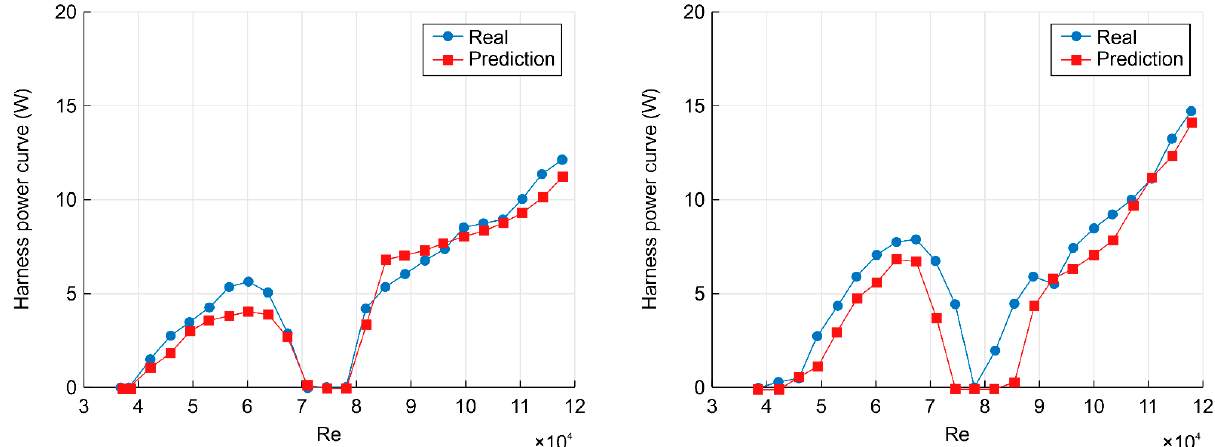
Figure 14. Power curves of real and predicted values for ζ harness = 0.16; K = 600 N/m (left) and ζ harness = 0.16; K = 1000 N/m (right).